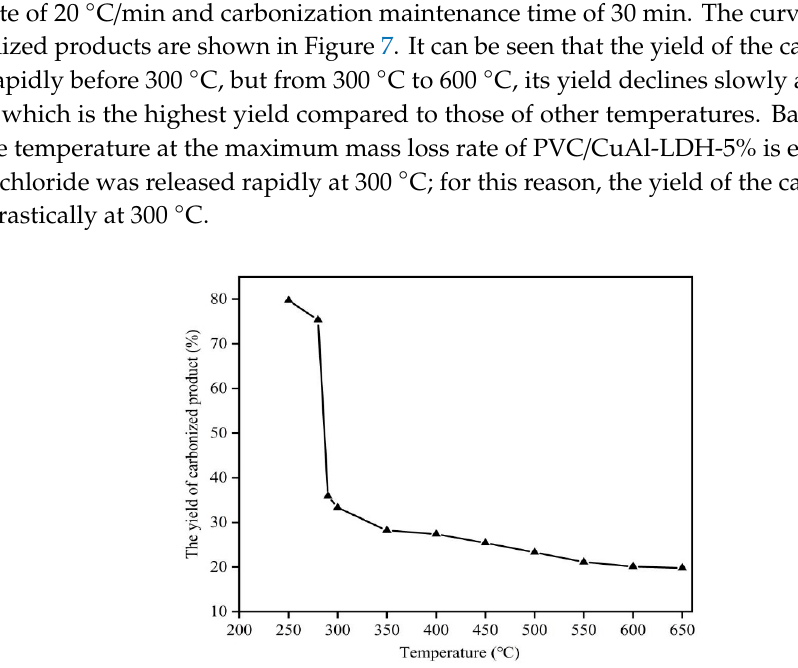
Figure 7. The curves for the yield of carbonized product different carbonization temperatures.